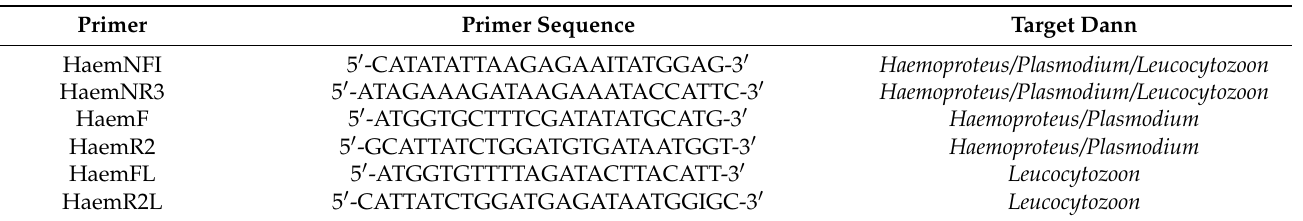
Primer sequences used for the amplification of blood parasite DNA (Haemopro-